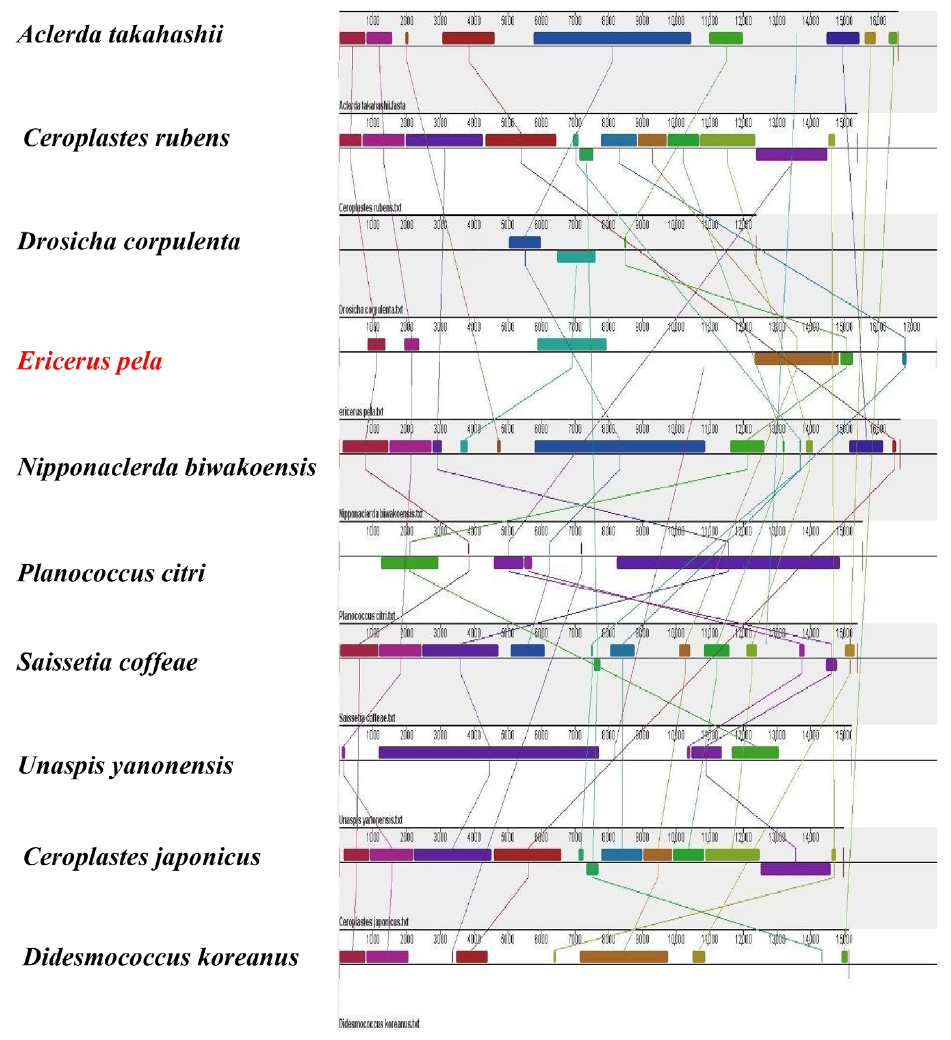
Figure 6. Synteny analysis based on whole mitochondrial genomes of 10 Coccoidea species. The solid-colored rectangles represent the homologous blocks among the selected species.